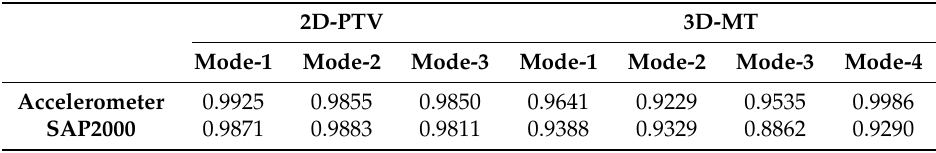
Table 3. Cross-MAC values of the mode shapes and operational deflection shapes obtained via 2D-PTV and 3D-MT, respectively, versus the mode shapes from the accelerations and SAP2000 modal analysis.